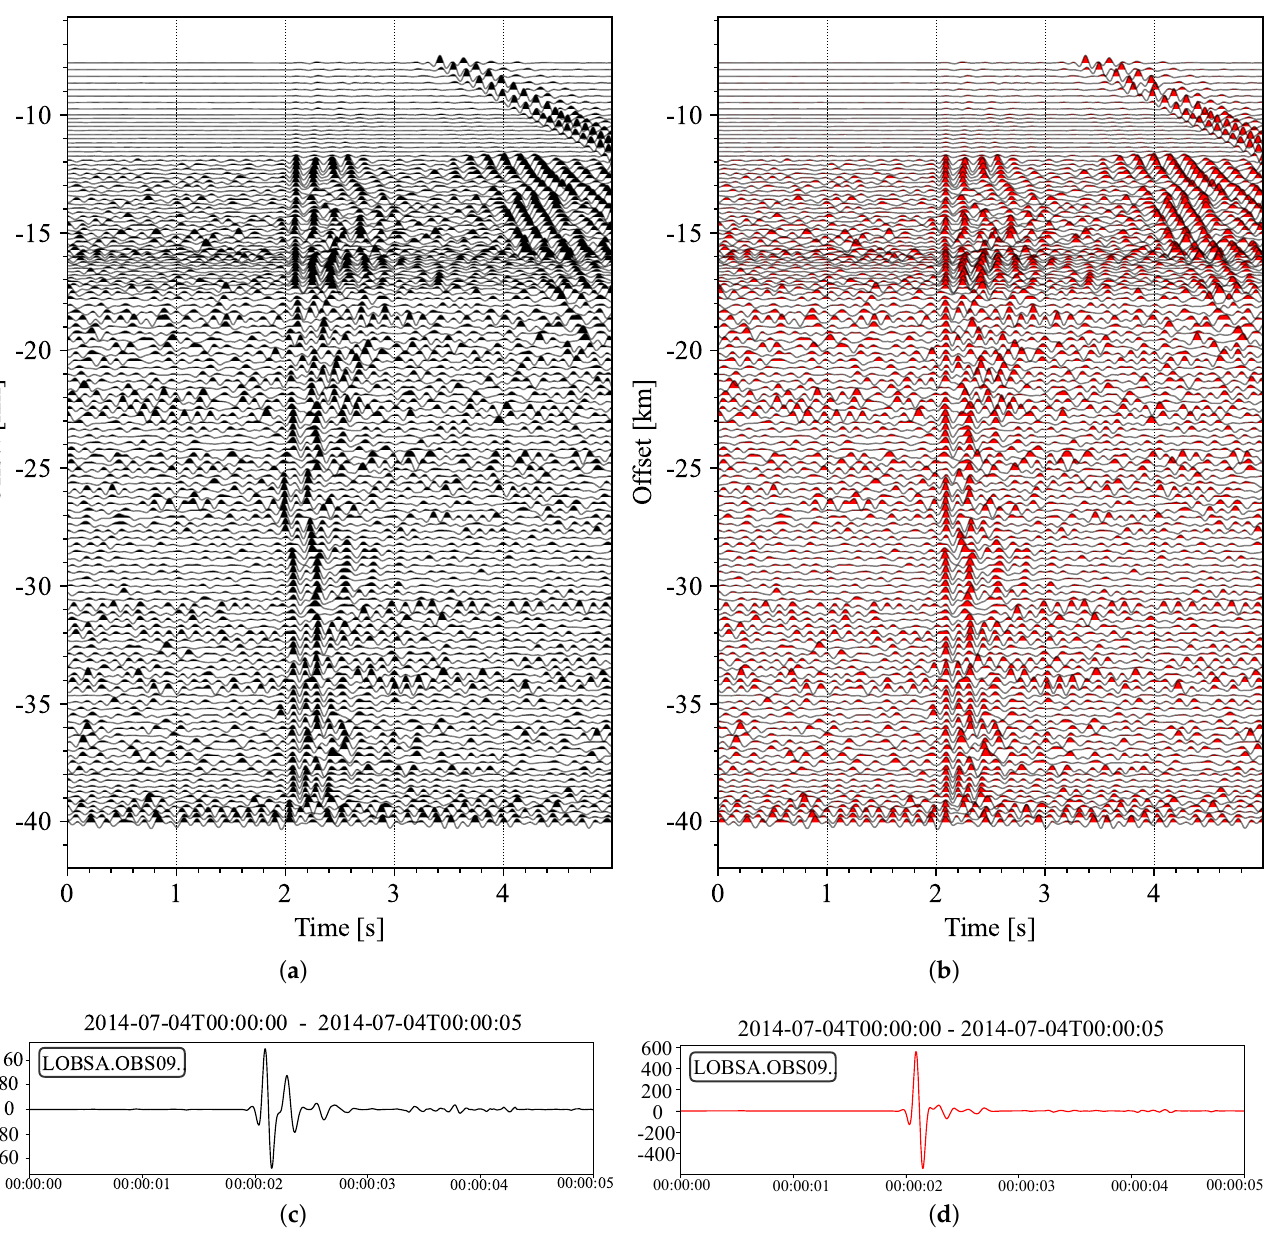
Figure 10. First-arrival seismic phase alignment corrected by moveouts: ( a ) base time; ( b ) the time obtained by post-correction after one iteration. ( c , d ) are the phase weighted stacking results of all seismograms in ( a , b ),